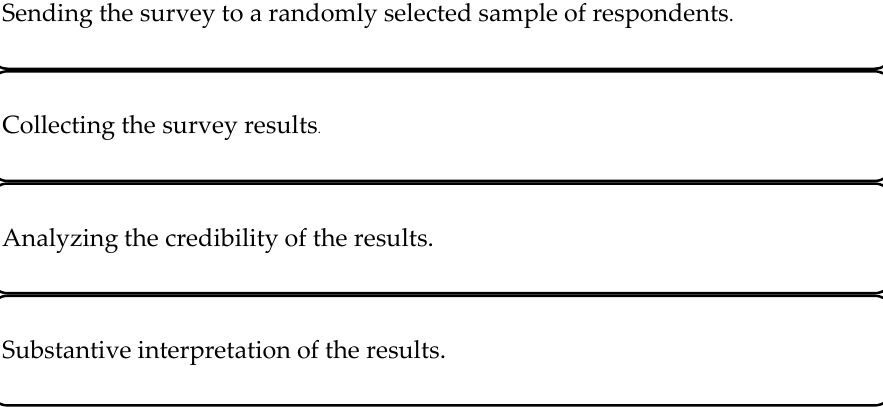
Figure 3. Block diagram presenting the research methodology.